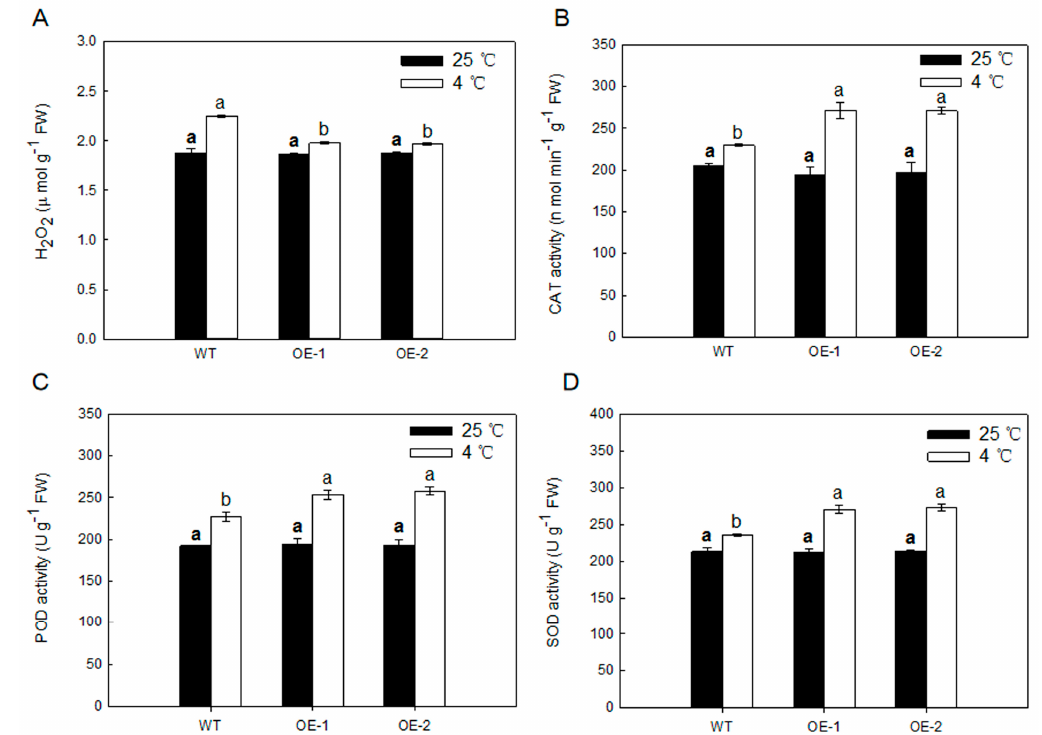
Figure 7. ( A ) Results of H 2 O 2 concentrations in leaves from WT and MdARD4 transgenic plants under both normal temperature and low temperature conditions and ( B – D ) antioxidative enzyme activities in leaves from WT and MdARD4 transgenic plants under both normal temperature and low temperature conditions: CAT ( B ), POD ( C ), and SOD ( D ). Data are means of three replicates with SD. Di ff erent letters indicate significant di ff erences between WT and transgenic plants on the same day of di ff erent treatments, according to one-way ANOVA Tukey’s multiple range tests ( p < 0.05).